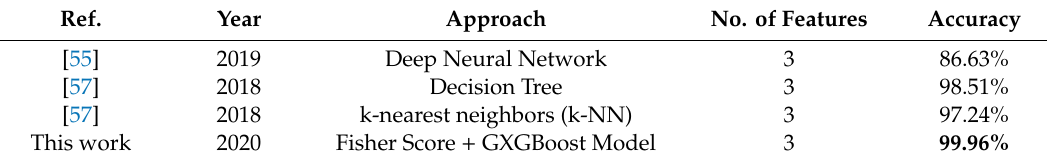
Table 13. Comparison of results with related works for Mirai, Bashlite, and benign classification tasks.